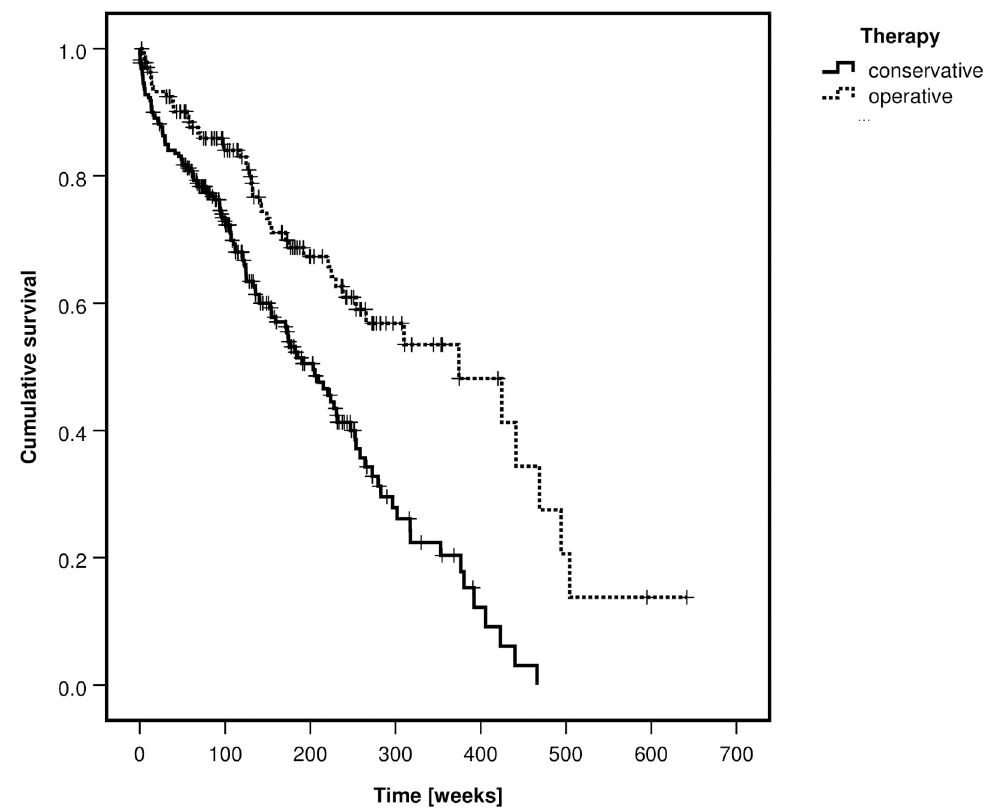
Fig 4. Kaplan-Meier curve of cumulative survival, depending on type of treatment—All patients.